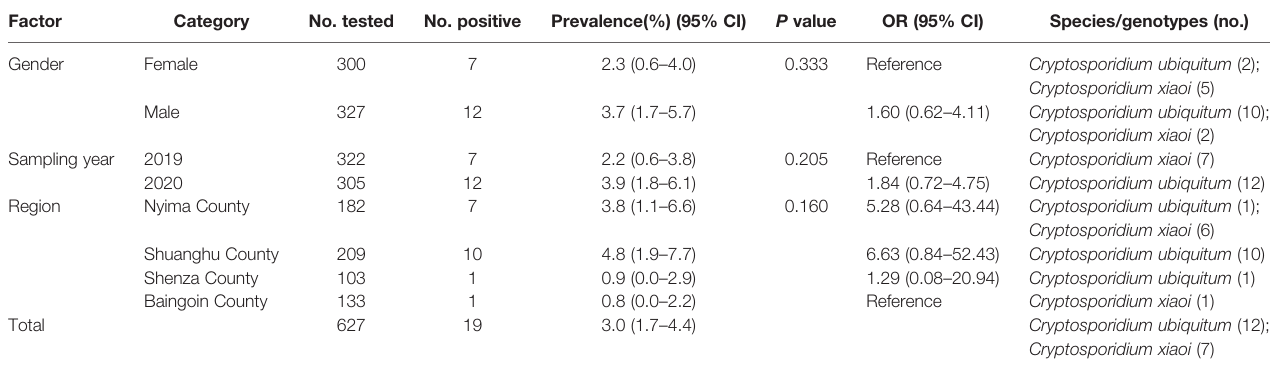
TABLE 1 | Prevalence and subtypes of Cryptosporidium infection in Tibetan Antelope ( Pantholops hodgsonii ) among different related factors. Factor